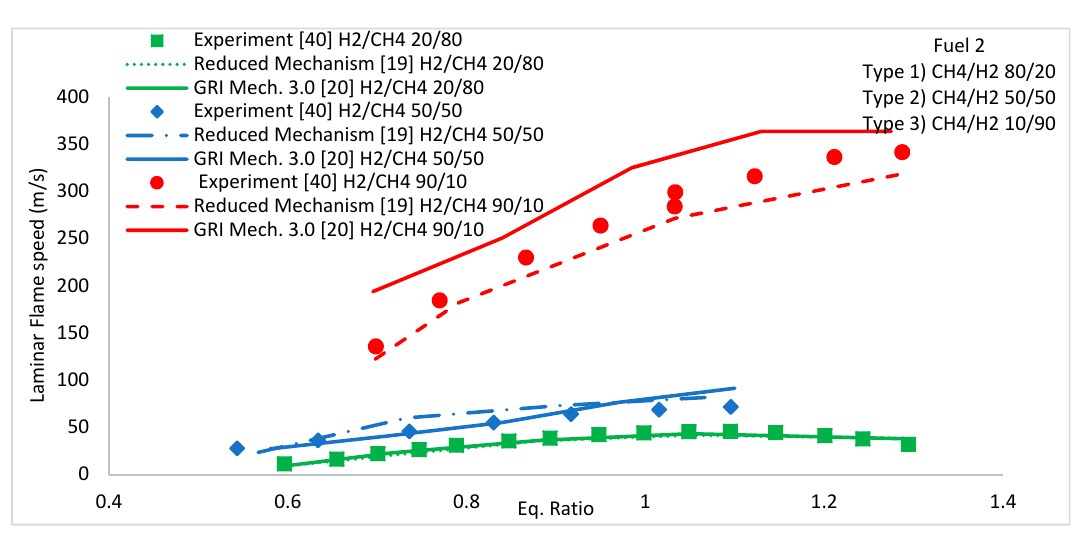
Figure 4. Comparison of the calculated laminar flame speed using the reduced mechanism [19] and GRI Mech. 3.0 [20] and the experimental measurements from Reference [40] for Fuel 2 (H 2 /CH 4 20/80%, 50/50% and 90/10%) at pressure 1 bar, eq.ratio 0.5–1.3 and temperature 298 K.